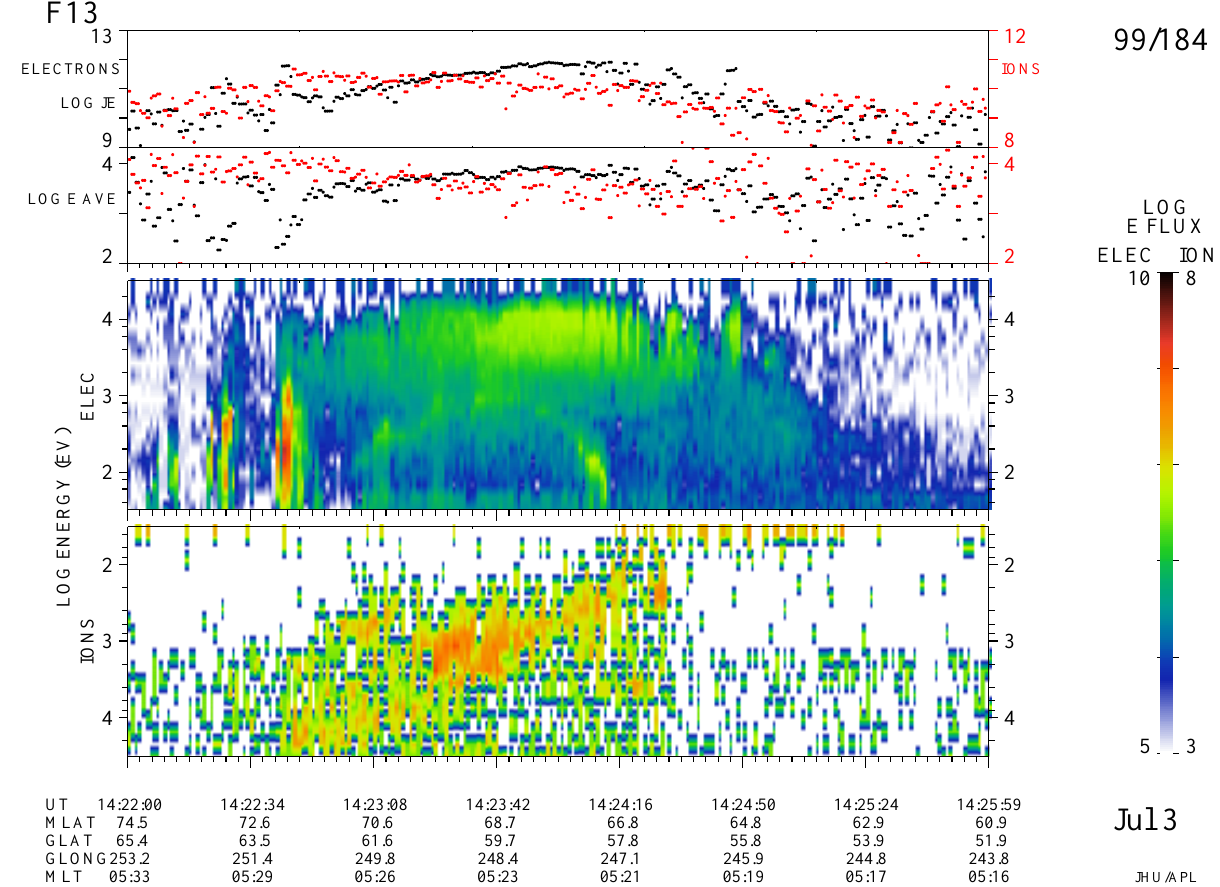
Fig. 8. DMSP F13 particle data from the conjugate point of the ion cloud observed by Astrid-2 on 3 July 1999, 14:15 (see Fig. 1). Color scale is differential energy flux in eV/(cm 2 s ster eV). (Courtesy Pat